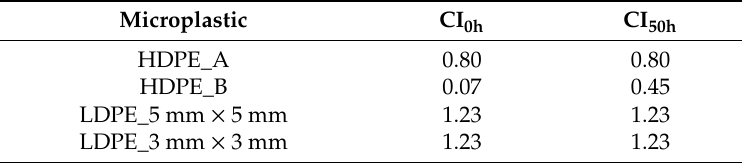
Table 3. Carbonyl index of MPs before and after photocatalytic